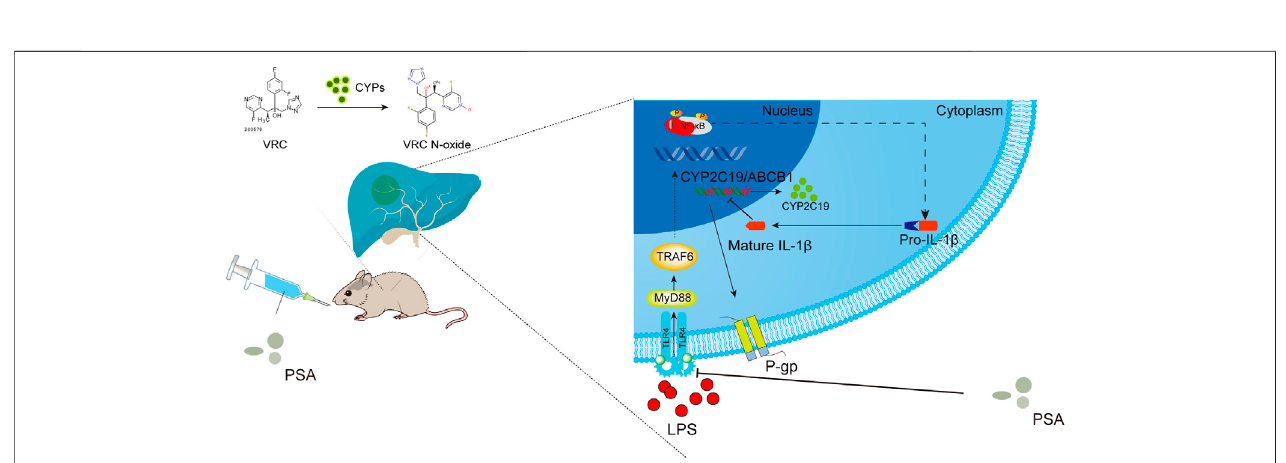
FIGURE 8 | Schematic illustration of PSA regulatory mechanism of VRC metabolism. PSA inhibits the TLR4/NF- κ B axis signal transduction pathway induced by LPS, suppressed the secretion of mature IL-1 β in the cytoplasm, promotes the expression of liver drug metabolic enzyme (CYP2C19) and transporter (P-gp and its protein coding gene ABCB1), and fi nally improves the metabolic ability of voriconazole.